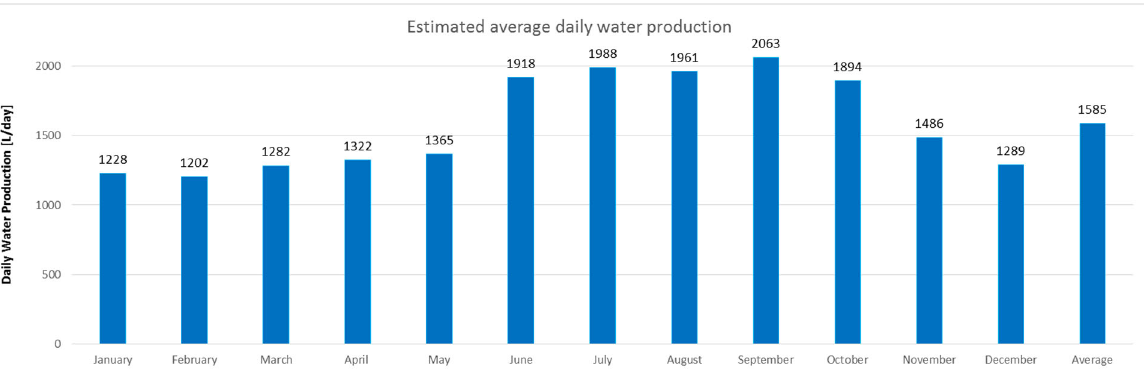
Figure 9. Average daily water production expressed in L/day.